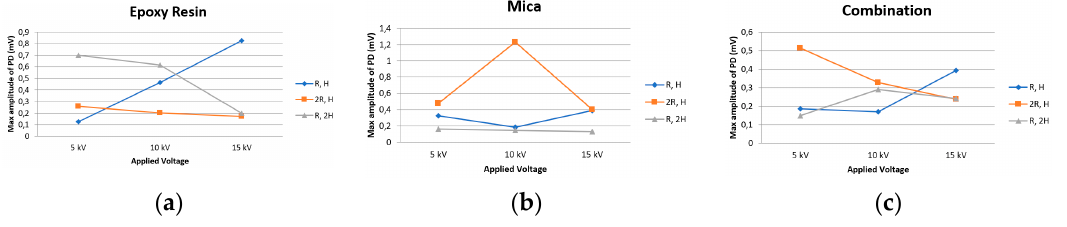
Figure 34. Maximum amplitude of PD for the 2nd model for ER ( a ), mica ( b ), and combination ( c ).